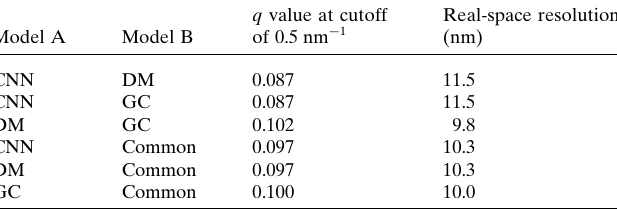
Table 2 The consistency levels between the reconstructed maps from four